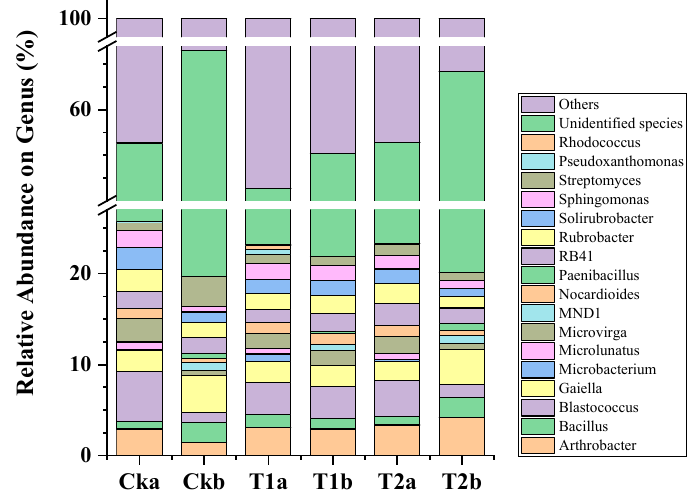
Figure 1. Soil bacterial community composition on genus level. Principal coordinate analysis revealed that the first two components explained 66.4% (PC1 of 53.7 % and PC2 of 12.7%) of the total variance of bacterial communities (Figure 2). Bacterial community of T1 was clearly differentiated from CK and T2 in subsurface soil, indicating a prominent effect of RERP with soil conditioner in deep soil layer. Bacterial community of surface soil samples demonstrated variations in PC2, with CK separated from T1 and T2.